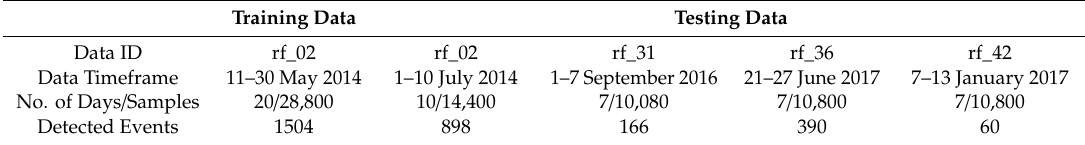
Table 5. Training and testing household data attributes and event detection results.